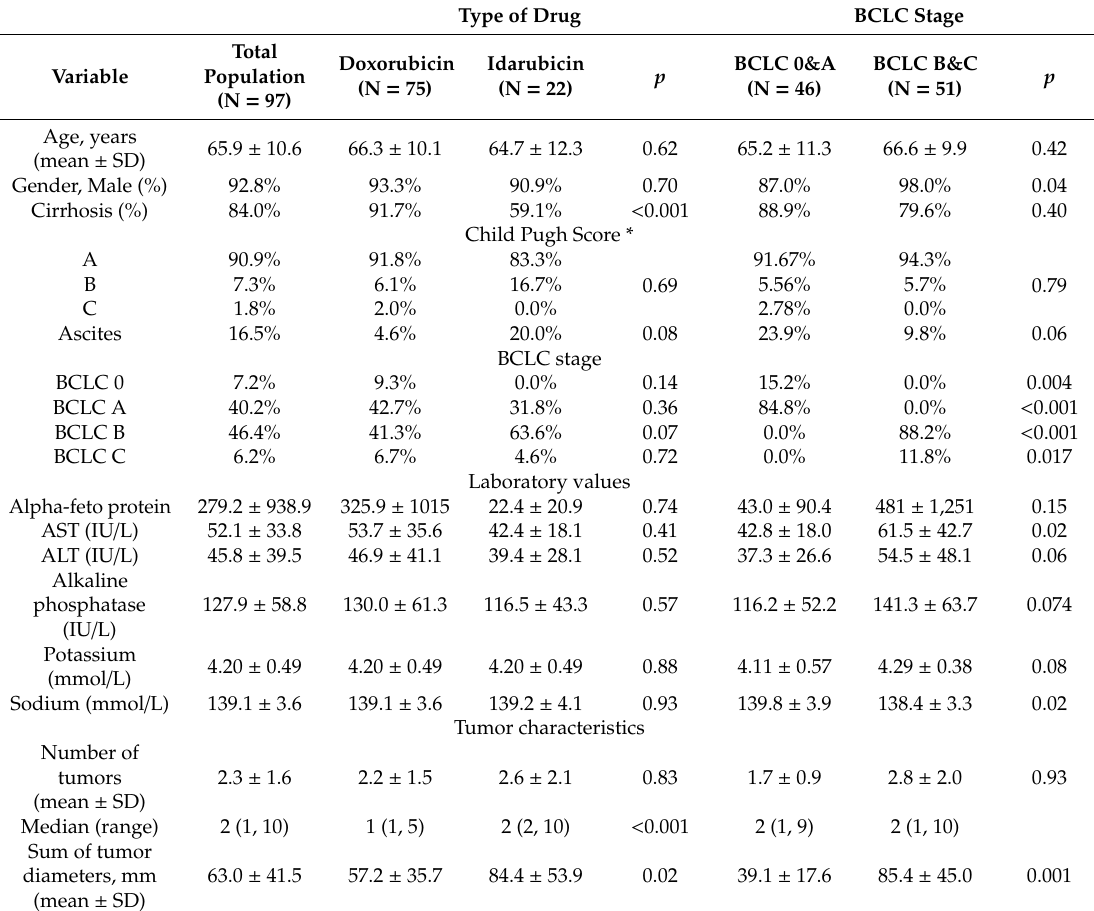
Table 1. Baseline characteristics of patients and tumors according to di ff erent subsets. Barcelona Clinic Liver Cancer (BCLC); aspartate aminotransferase (AST), alanine aminotransferase